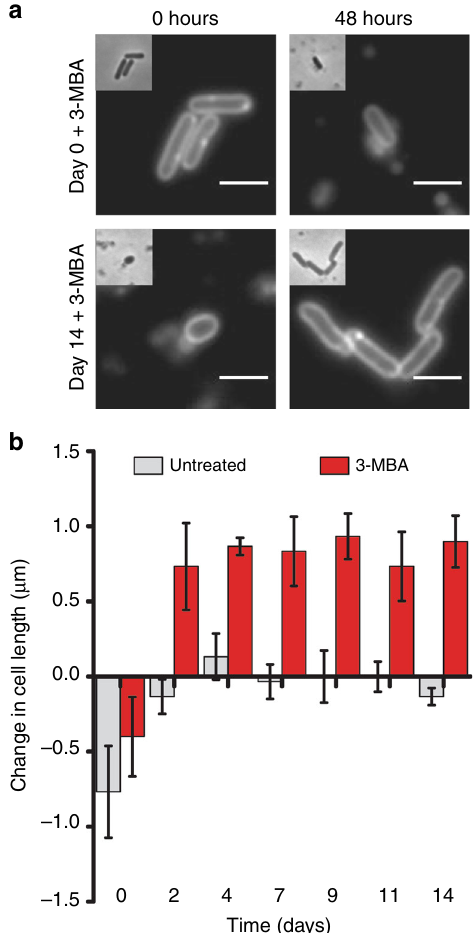
Fig. 7 Cell growth under deep starvation conditions. B. subtilis Δ spoIIE cells (strain DG001) were incubated for 14 days in starvation buffer. At regular time intervals samples were withdrawn and incubated with the cell division inhibitor 3-methoxybenzamide (3-MBA) for 48 h. a Cells were stained with the fl uorescent membrane dye FM5-95 in order to determine cell length before and after 3-BMA treatment. Scale bar is 2 µ m. b Average change in cell length was calculated for approximately 100 individual cells for each time point. Bar diagram depicts the average and standard deviation of